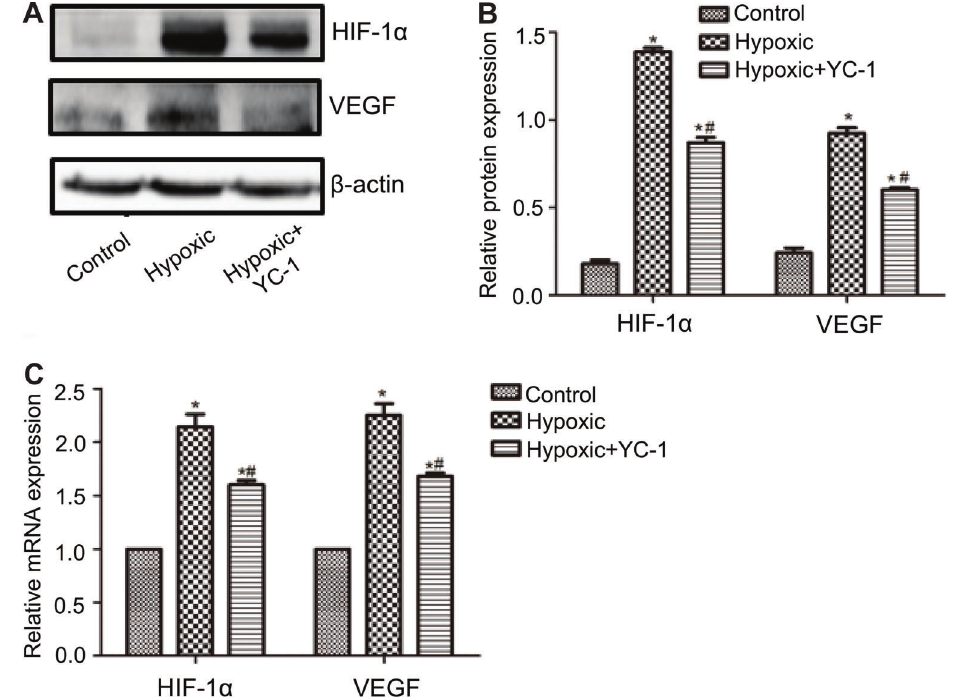
Figure 2. A , HIF-1 a and VEGF expression. B , Histogram of HIF-1 a and VEGF protein expression. C , Histogram of HIF-1 a and VEGF mRNA expression. Data are reported as means ± SD. *P o 0.05 compared with normal control group; # P o 0.05 compared with hypoxic group (ANOVA). Time of incubation with YC-1=48 h.